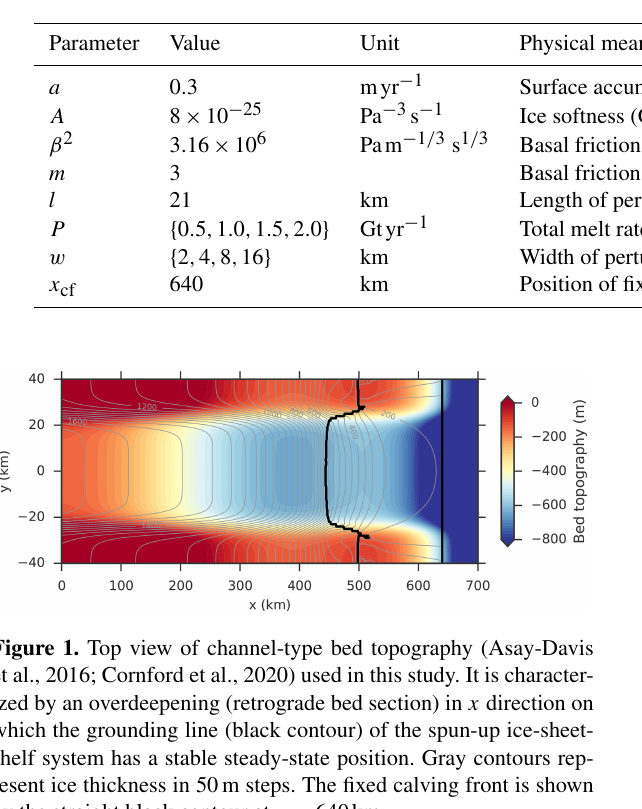
Table 1. Parameters and their values varied throughout the experiments.